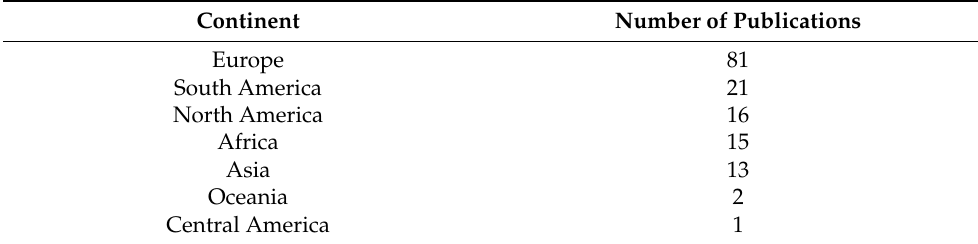
Table 1. Number of publications reporting cephalosporinases in wildlife per continent.